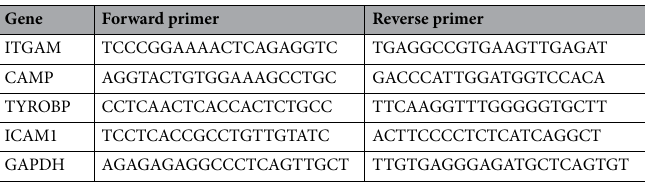
Table 3. PCR primers for quantitative real-time